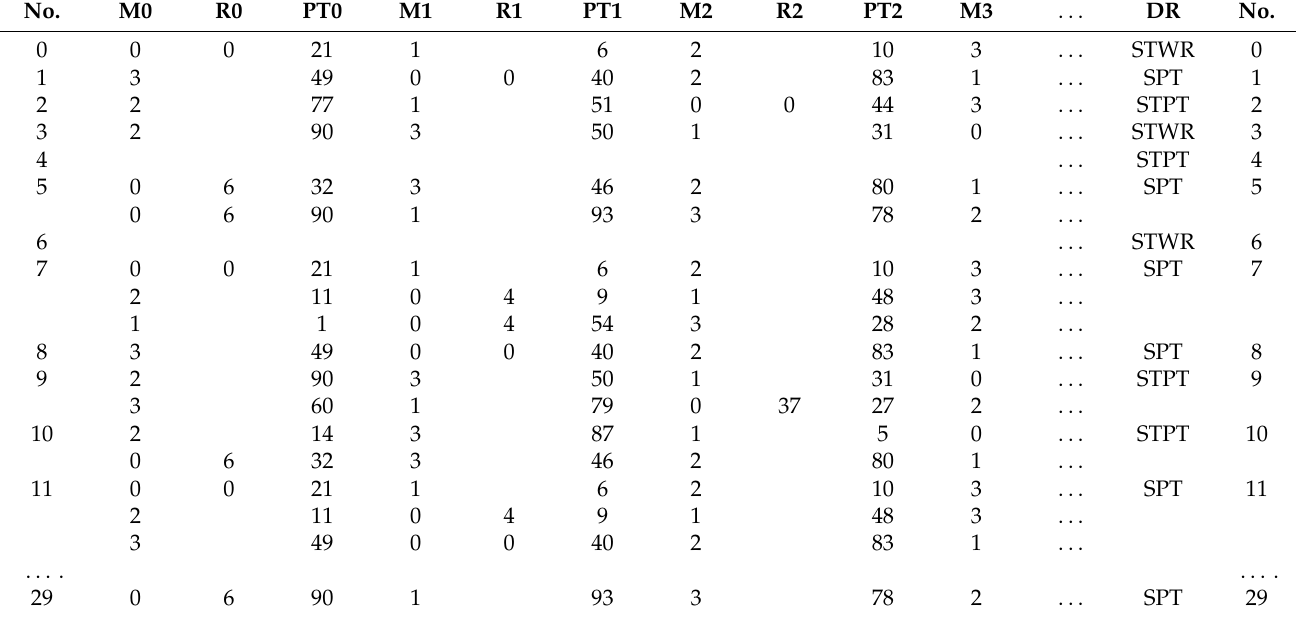
Table 9. Raw data with scheduling knowledge (four machines and 10